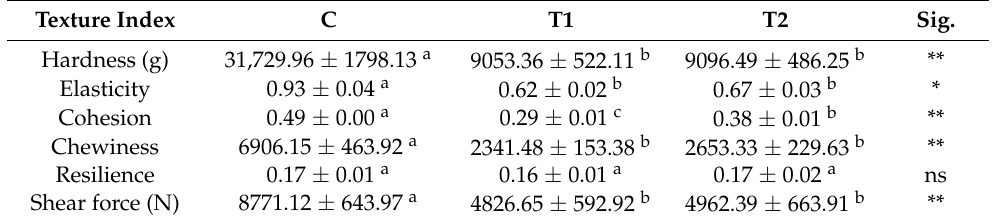
Table 3. The improvement in the texture of MPR.